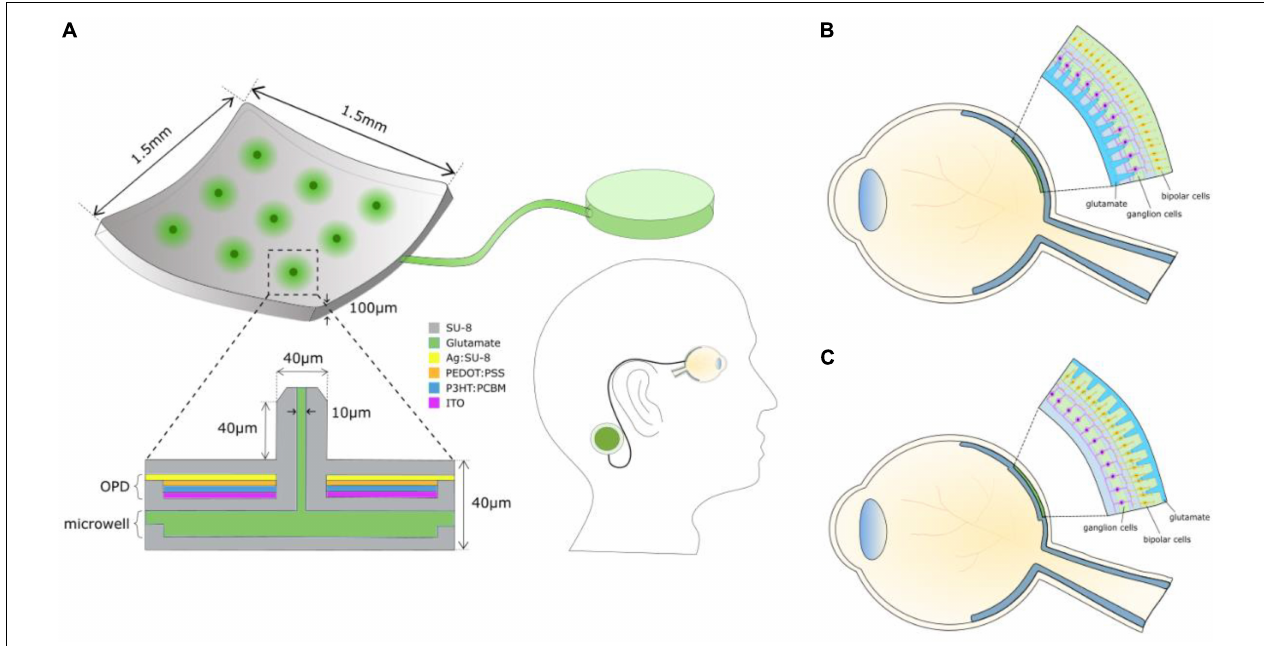
FIGURE 1 | (A) Schematic of the components of a chemical retinal prosthesis for implantation. Envisaged is an implantable chip containing an array of glutamate injection microneedles, each fed from an intraocular well of glutamate, which is itself connected to an external large reservoir of glutamate, perhaps situated behind an ear. The needle-like ports permit penetration into the retina, securing the device and locating glutamate release close to its cellular targets. Glutamate release is envisaged to be controlled by a photoinduced electric field of an integrated organic photodiode (OPD) formed around each microneedle inducing electroosmotic actuation. (B) Epiretinal placement of the needle array. (C) Subretinal placement of the needle